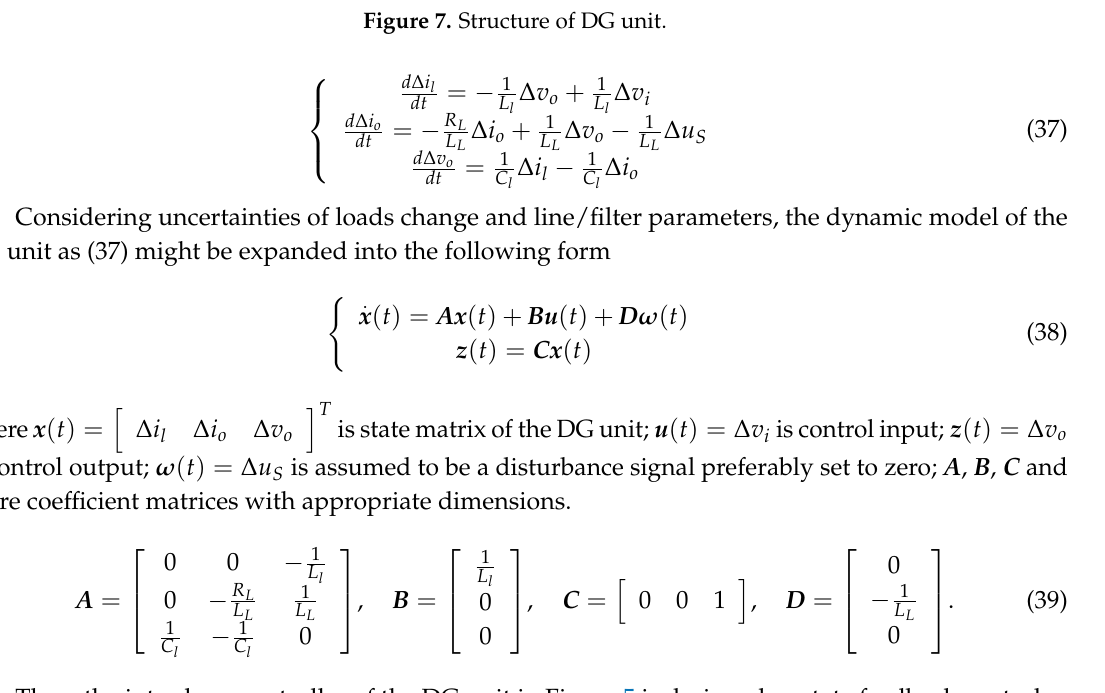
Figure 7. Structure of DG unit.